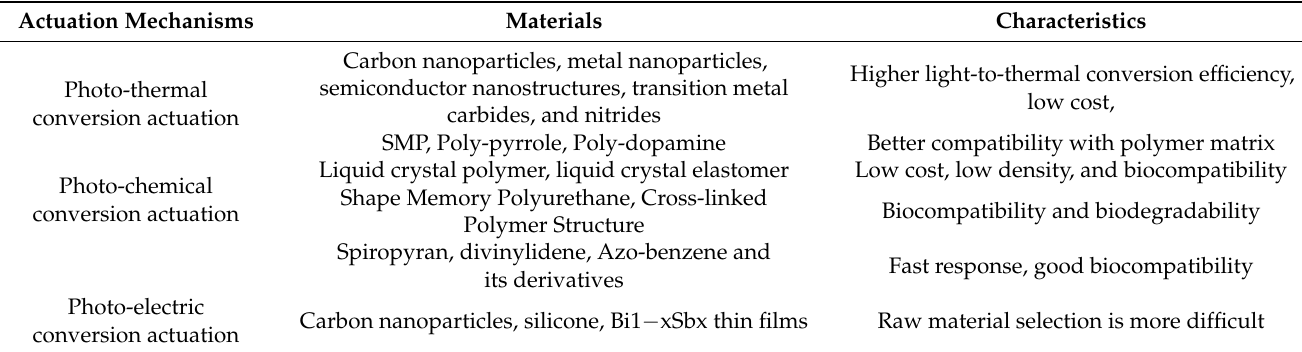
Table 1. Actuation mechanism, materials, and characteristics of light-responsive